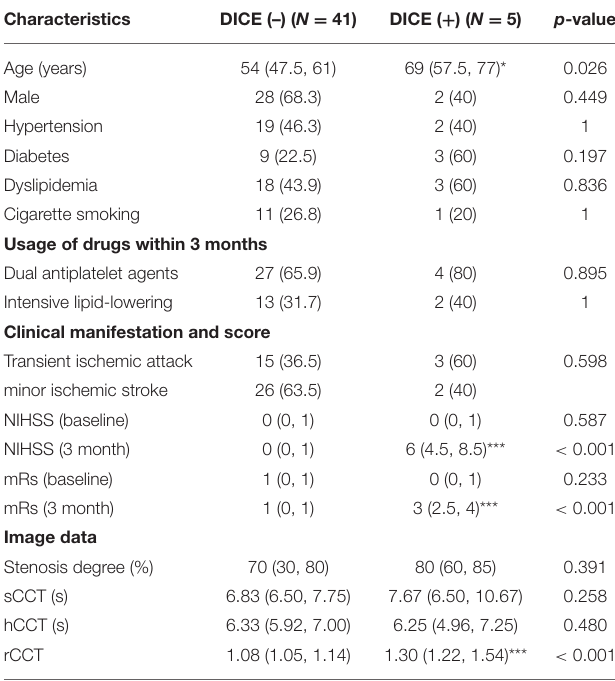
( Table 3 , Figure 3 ). In contrast, the optimal cutoff point of sCCT (9.5 s) predicted DICE with 40% sensitivity and 100% specificity; the optimal cutoff point of stenosis degree (65%) predicted DICE with 100% sensitivity and 43.9% specificity